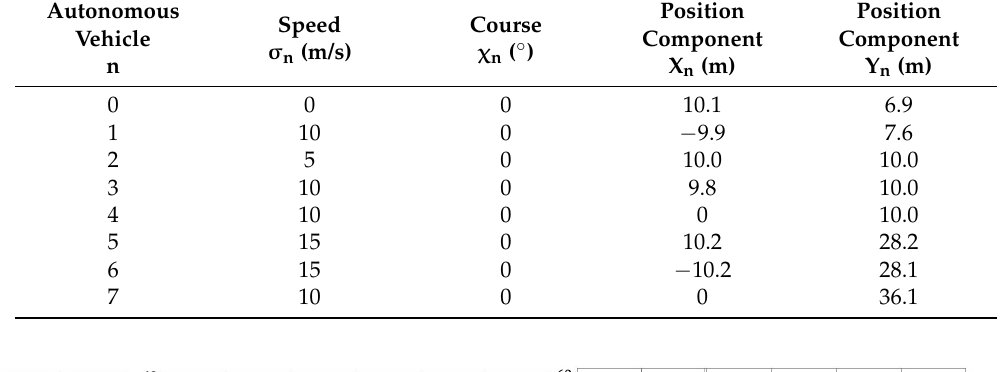
Figure 11. Safe game trajectory of our autonomous vehicle in multidirectional traffic when passing seven other cooperating autonomous vehicles for three safe passing distance values.